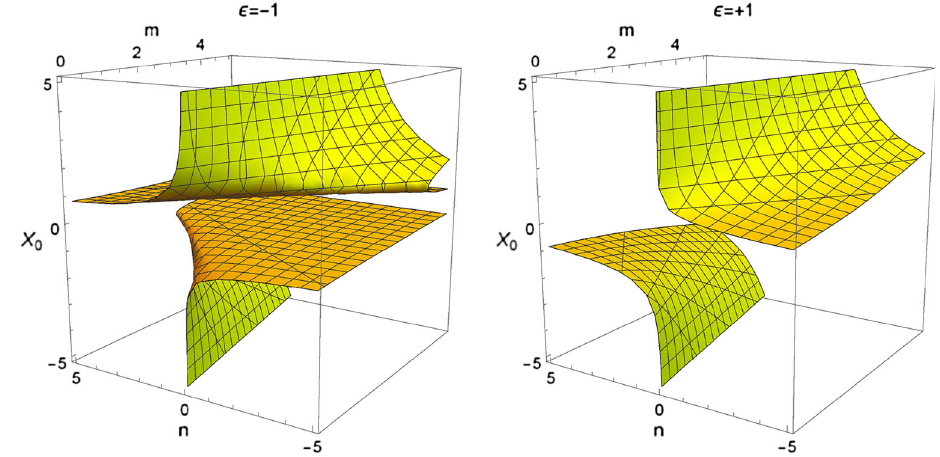
Fig. 5 The variation of X 0 versus typical values of the m and n parameters in (49) for the radiation background